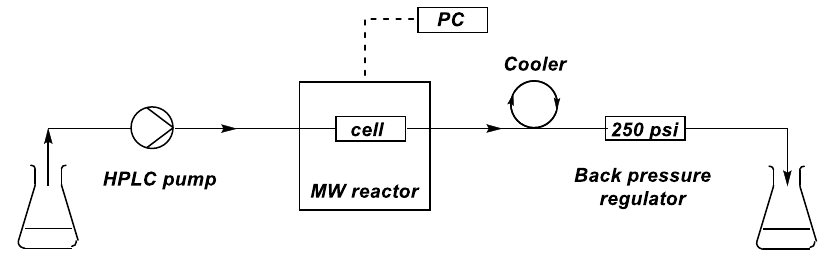
Figure 1. Schematic drawing of the continuous flow system developed.